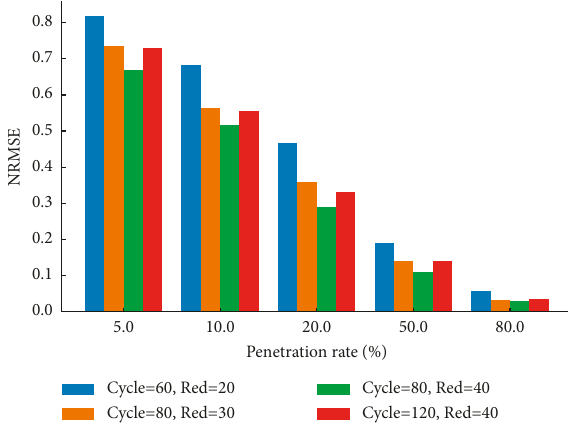
Figure 10: NRMSE analysis for different cycle and red